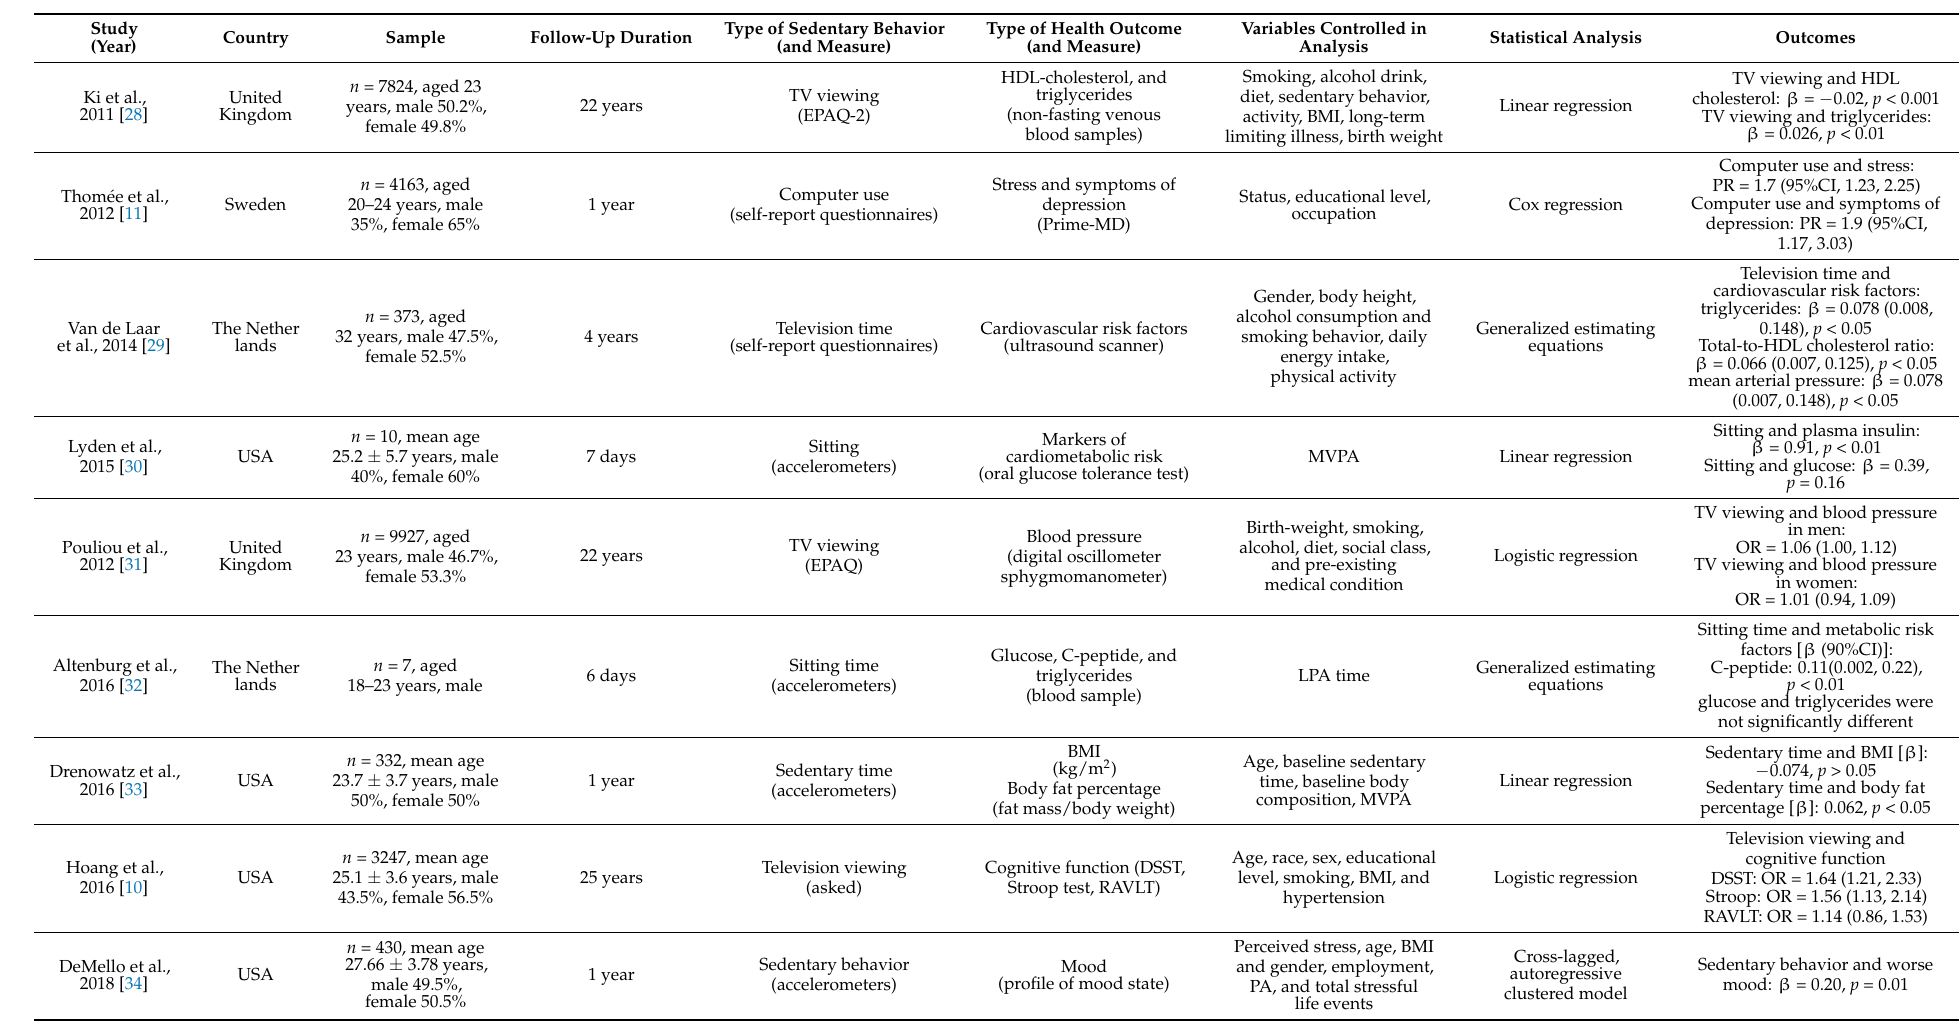
Table 1. The study